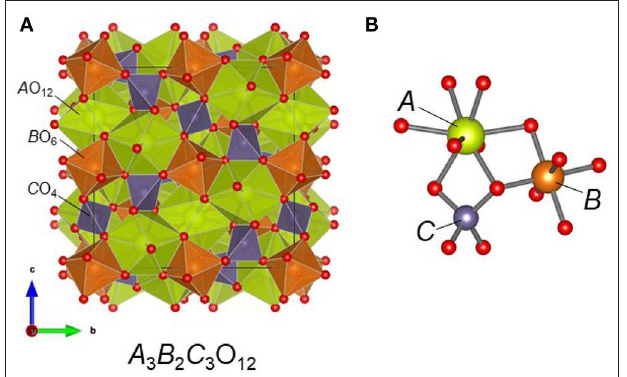
FIGURE 1 | (A) Crystal structure of the garnet compound A 3 B 2 C 3 O 12 and (B) the local coordination environment around the metal cations. In Ce 2 CaMg 2 Ge 3 O 12 , Ce/Ca, Mg, and Ge atoms occupy the A, B, and C sites, respectively.